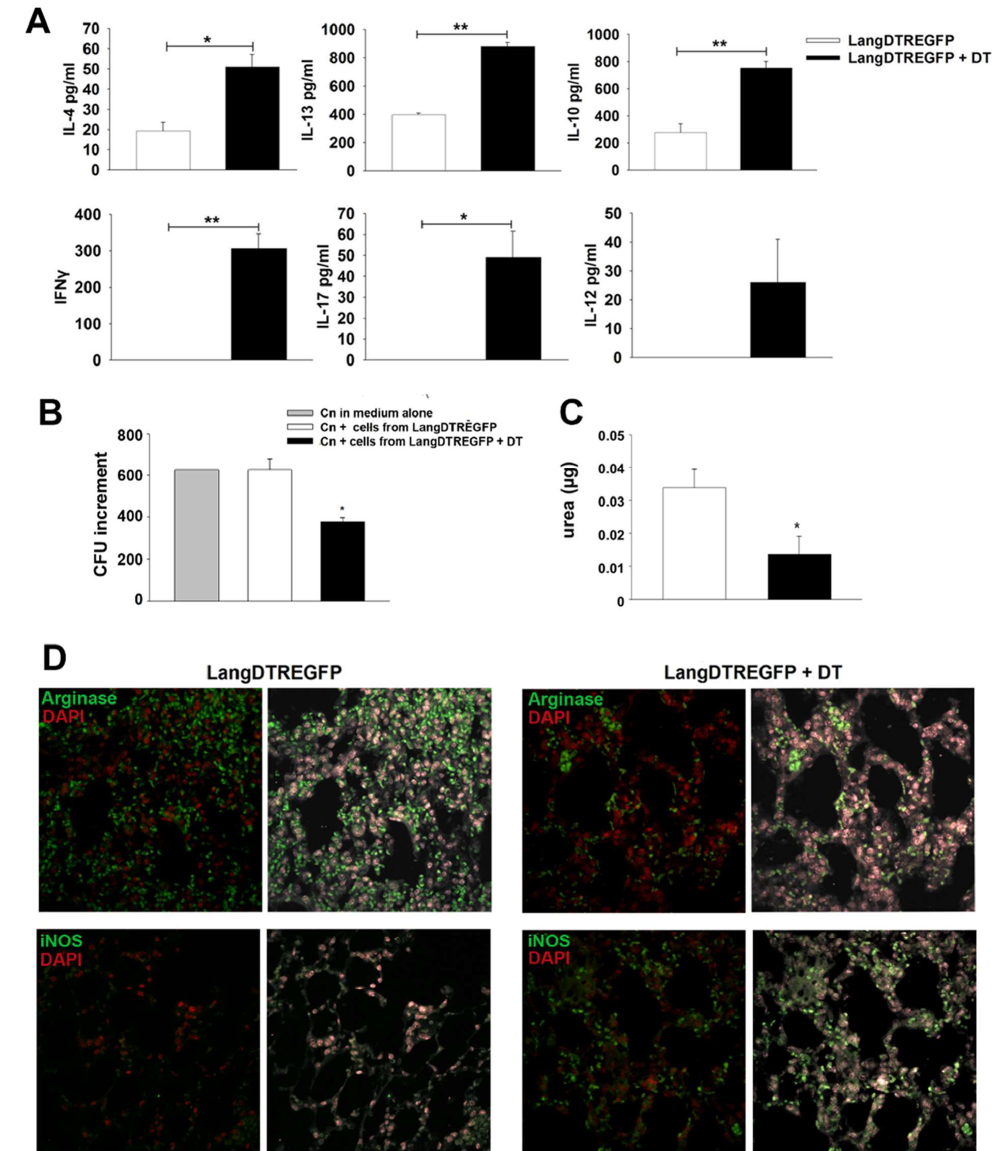
Figure 3. Ex vivo cytokine production, fungal growth inhibition and arginase-1 or iNOS expression by lung cells from C. neoformans -infected mice. ( A ) Cytokine production by lung cell suspensions obtained from DT-treated (black bars) or untreated (white bars) LangDTREGFP mice at 7 days post infection. Bars represent cytokine levels (ELISA) in 24 h culture supernatants. * p < 0.05; ** p < 0.005. ( B ) In vitro C. neoformans growth assay using a yeast suspension (1 × 10 3 ) cultured in medium alone (gray bar) or in the presence of adherent lung cells from untreated (white bar) or DT-treated (black bar) 7-day-infected LangDTREGFP mice. Bars represent ratio of final vs initial CFU numbers in each culture condition. ( C ) Arginase activity from lysates of adherent cells cultured in (B), measured as urea production (µg of urea per µg of protein). * p < 0.05. Data are expressed as mean ± SEM. The data shown are pooled from two independent experiments ( n = 6 animals per group; samples from each animal were analyzed in triplicate ( A , C ) or duplicate ( B )). All data were analyzed with Student’s t -test or ANOVA. ( D ) Confocal microscopy of representative lung sections from 7-day-infected mice ( n = 6) after immunostaining with fluorochrome-labeled specific antibodies to arginase-1 (upper panels) or iNOS (lower panels). 600 × magnification. DT: diphtheria toxin; dpi: days post infection; CFU: colony-forming